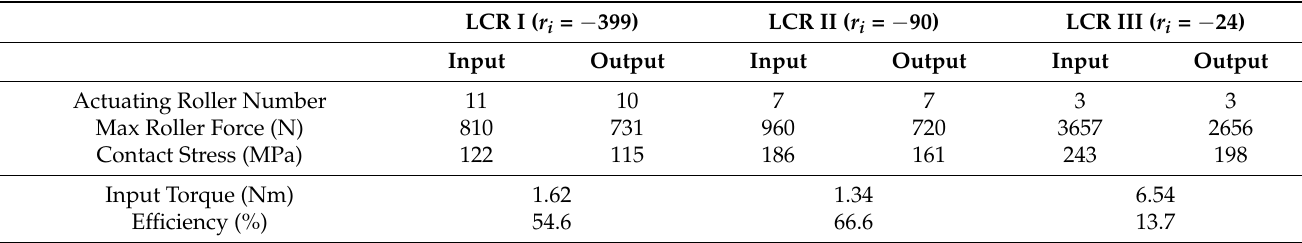
Table 3. Characteristic analyses of three lobe cam reducers ( T o = 80